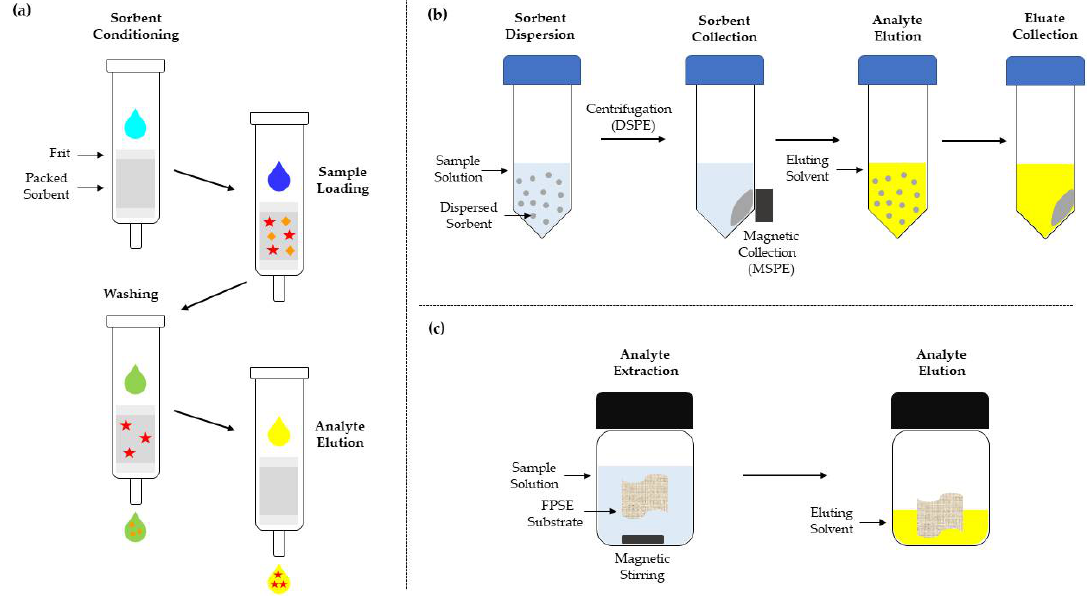
Figure 2. Schematic representation of the basic steps in ( a ) SPE, ( b ) DSPE and MSPE, and ( c )